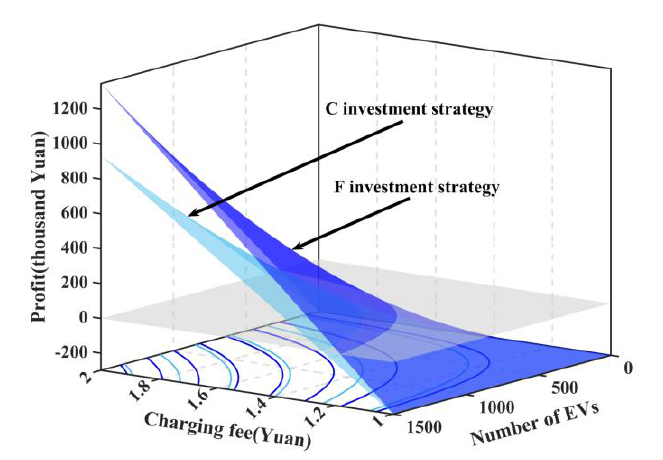
Figure 5. ECF-investment profit changes with the charging fee and number of